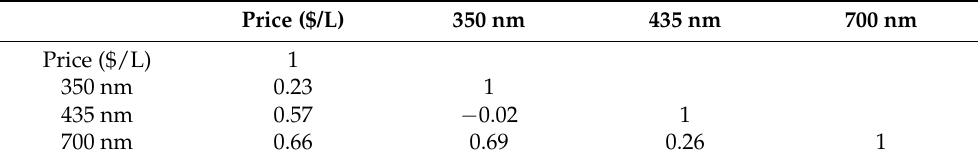
Table 2. Correlation table relation of price to emission wavelength—R values.